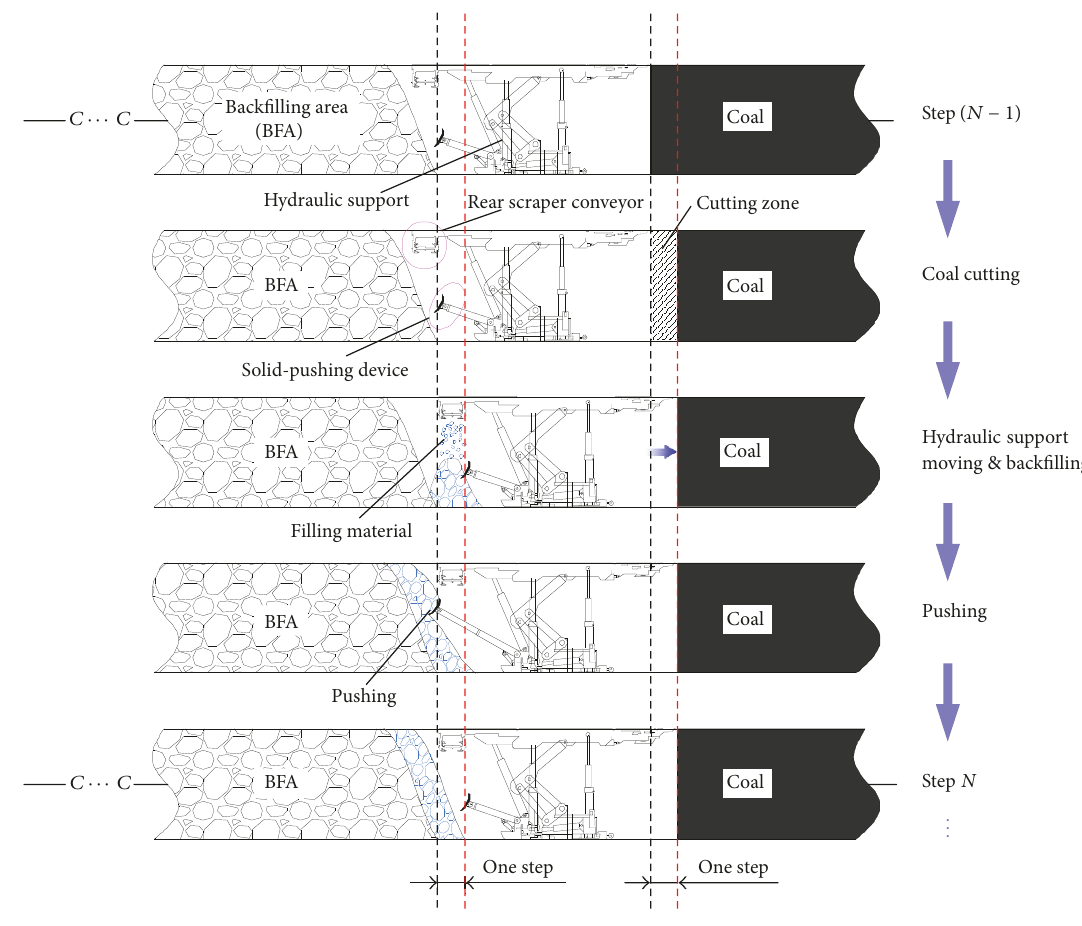
Figure 8: Backfilling mining step